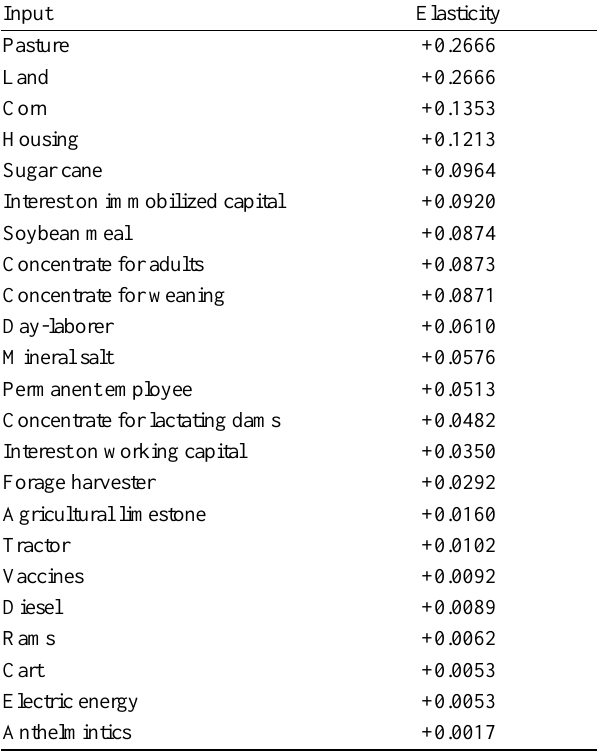
Table 5. Price elasticities of production factors of the total cost for representative property of Sao Jose do Rio Preto: percentage change that would happen in the total cost of production by 1% increment in the price of the relevant production